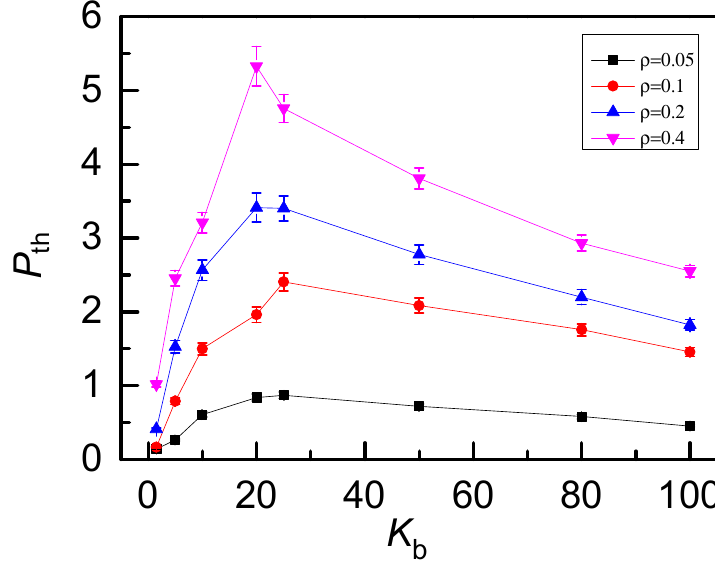
Figure 12. Average threading number P th of 0 1 -knot rings as a function of bending energy K b for different number densities ρ . P th increases with the increase of the number density.